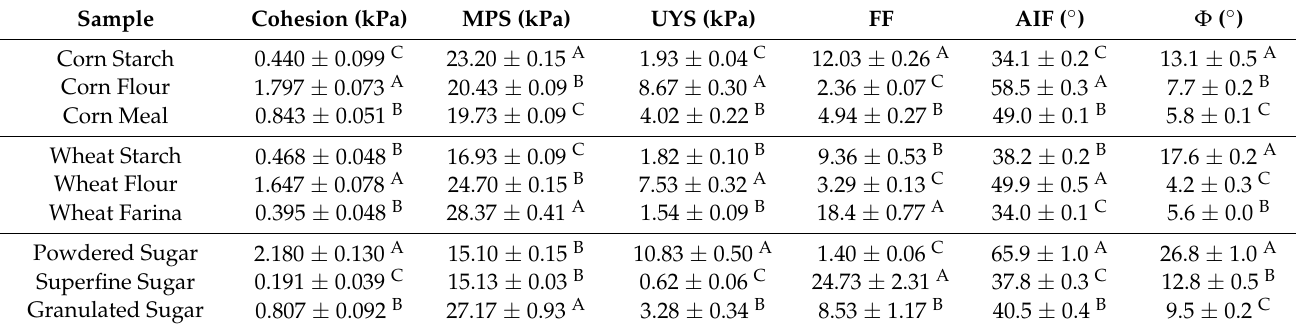
Table 3. Shear flow properties of food